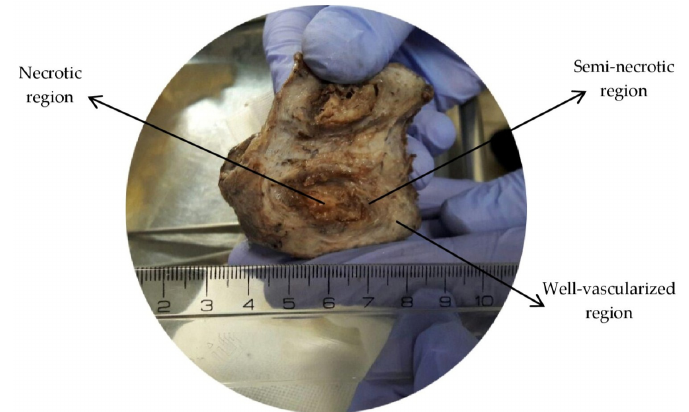
Figure 1. Geometry of studied tumor with different parts.